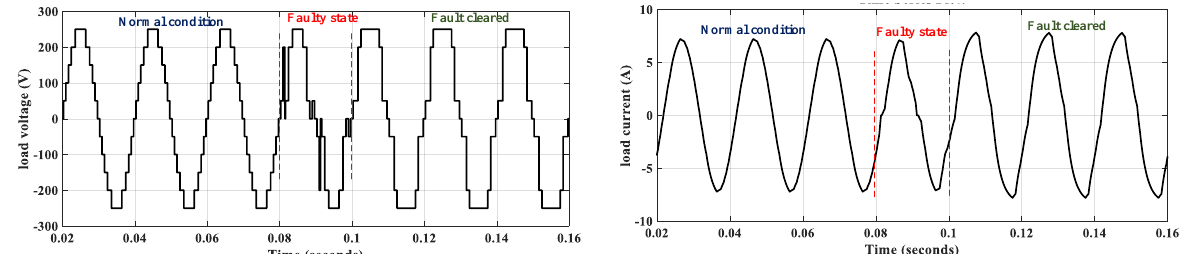
Figure 17. Simulation voltage and current waveforms under S 7 fault.